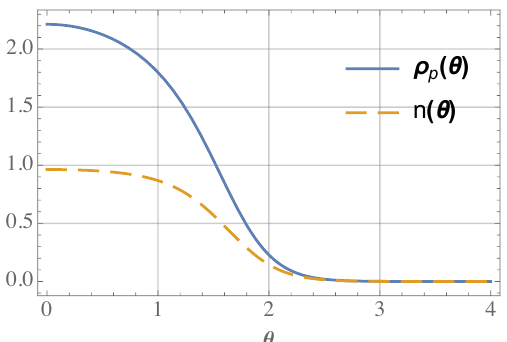
( θ ) and filling function n ( θ ) for a thermal gas at p